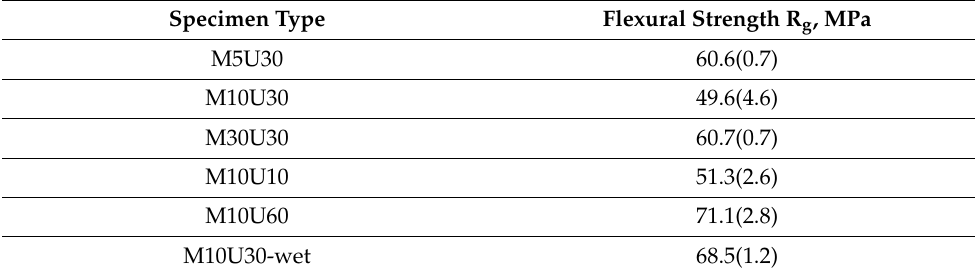
Table 3. The results of static bending tests of the produced